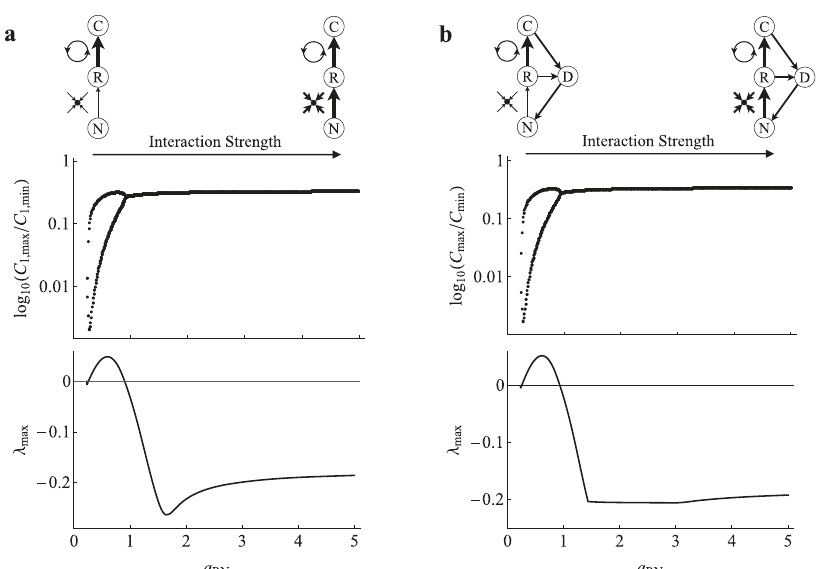
Fig. 6 Nutrient-limited ecosystem module stability. a , b Non-equilibrium dynamics (log 10 ( C max / C min )) and equilibrium stability (real part of the dominant eigenvalue; λ max ) of the C – R – N nutrient-limited food chain model and the C – R – N – D nutrient-limited ecosystem model, respectively, as a RN is